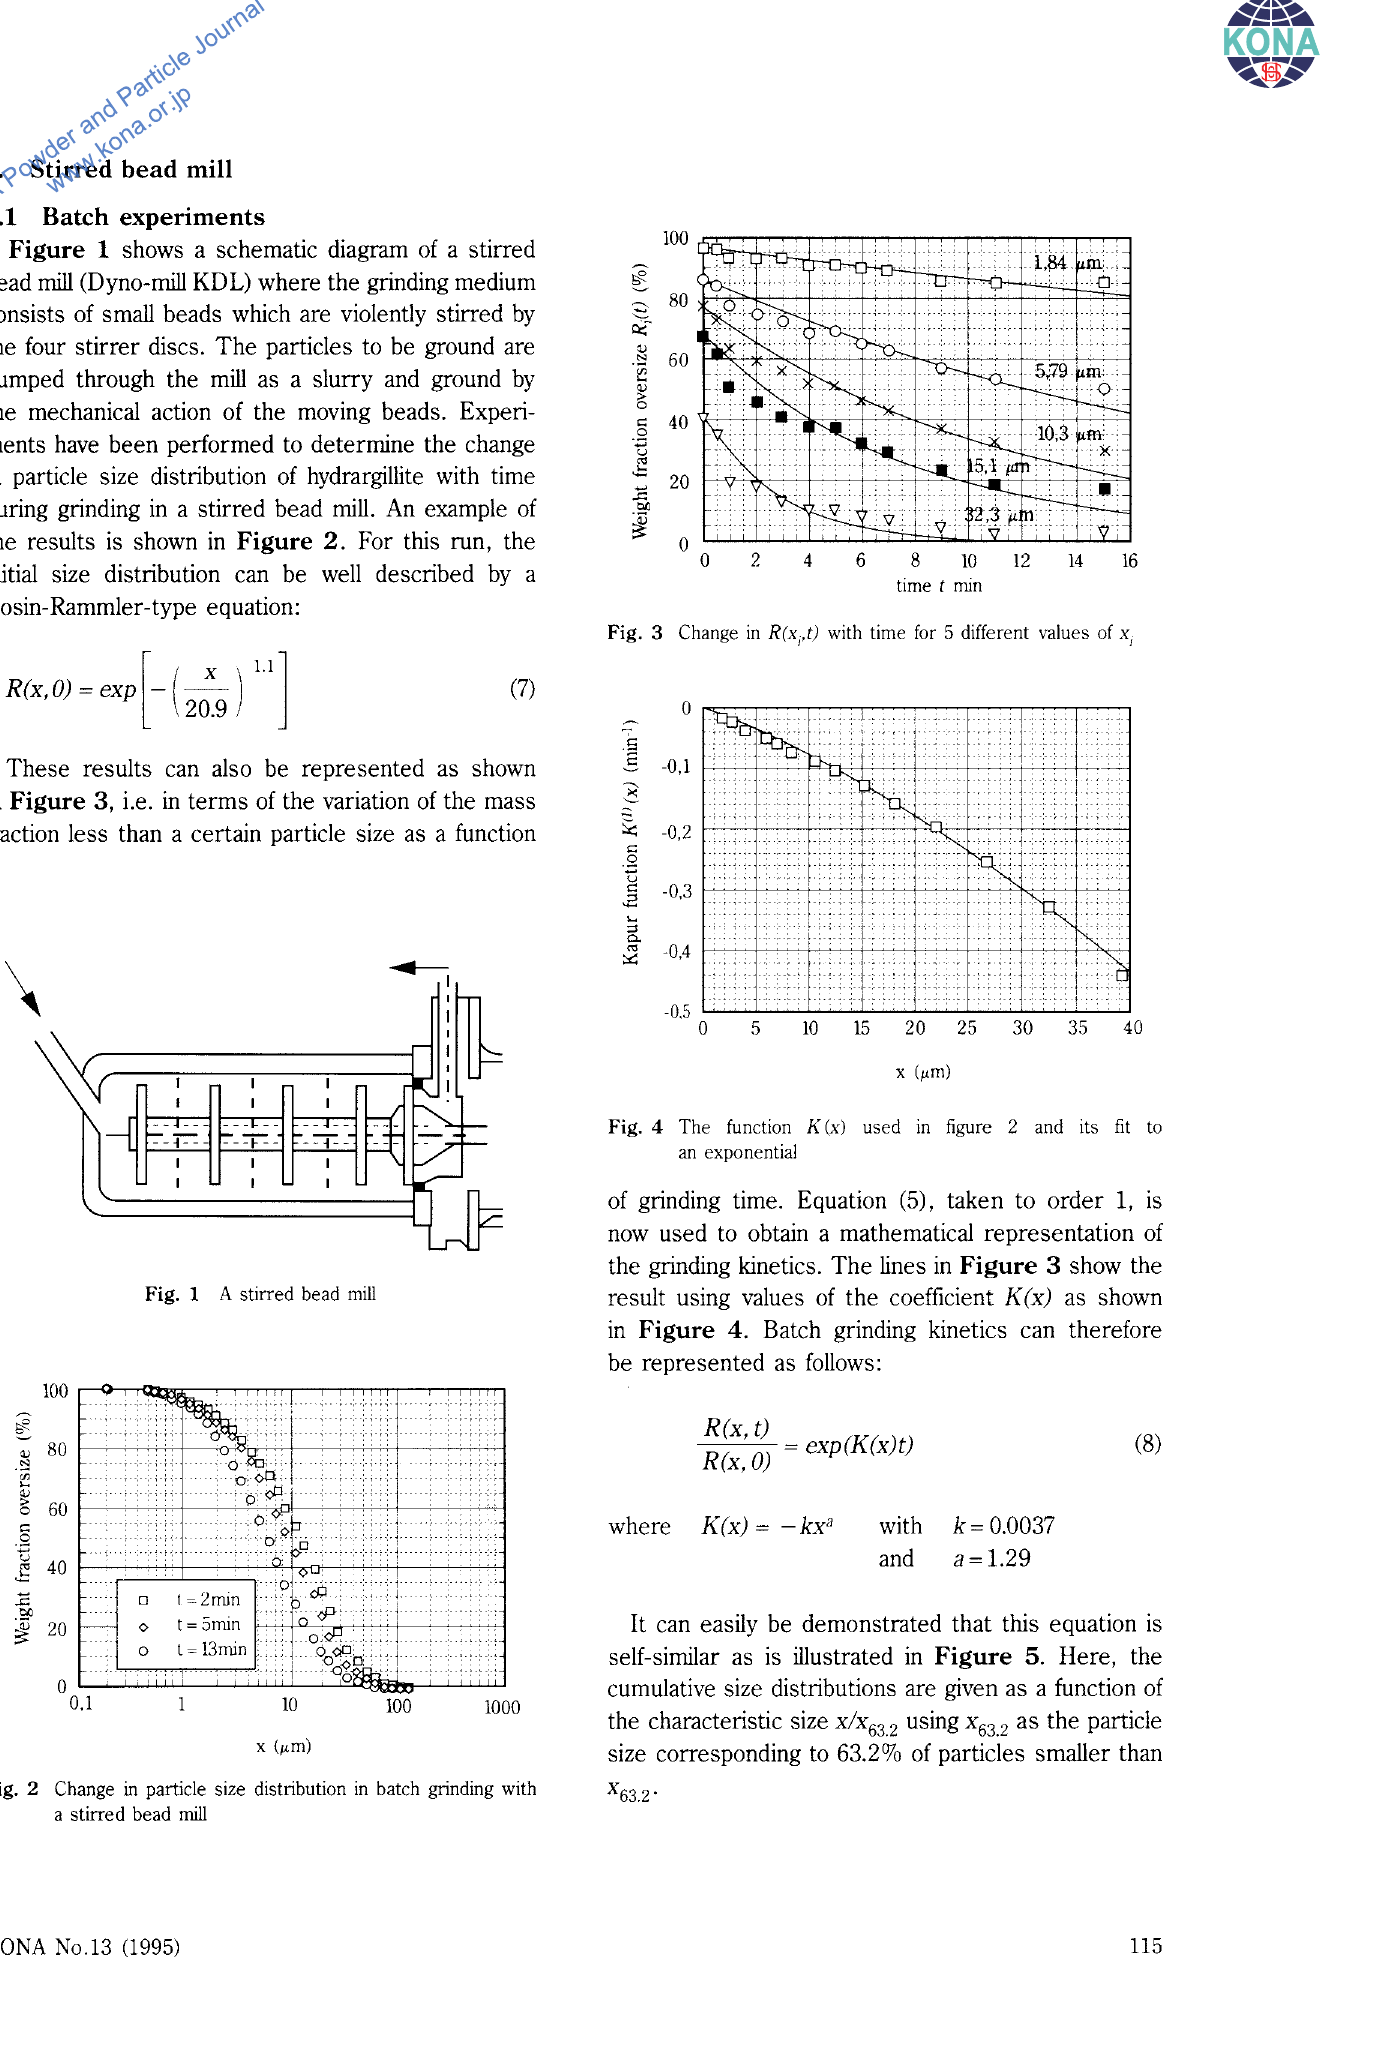
Fig. 2 Change in particle size distribution in batch grinding with